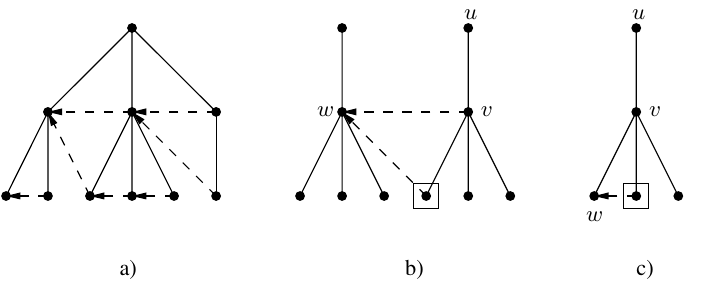
Figure 1: a ) An example of the decomposition of an outerplanar graph. b ) A vertex of Type 1. c ) A vertex of Type 2.